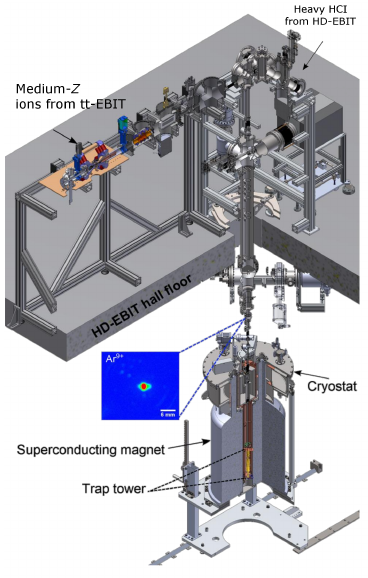
Figure 6. Overview of the ALPHATRAP ion sources. The tt-EBIT provides few-electron ions of low to medium Z . Recently, the extraction and transport of highly charged ions from the tt-EBIT to the end of the room-temperature beamline has been demonstrated. The connection to the HD-EBIT gives access to few-electron ions up to the highest Z